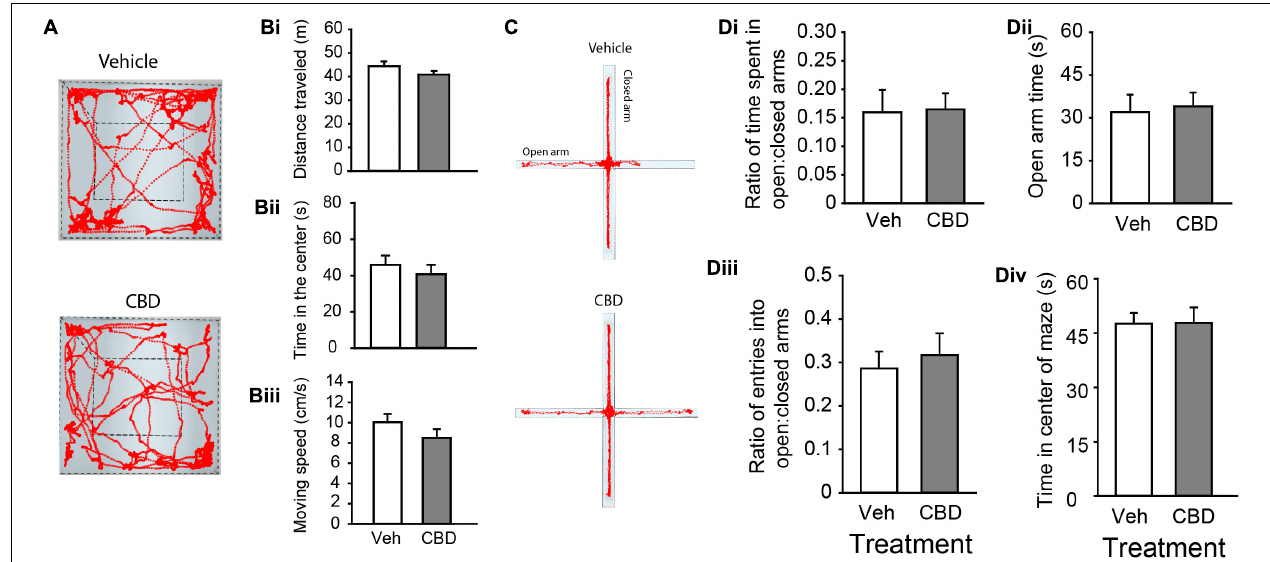
FIGURE 2 | Adolescent CBD exposure does not impact locomotor or anxiety-related behaviors. (A) Representative activity traces in the open field of subjects administered vehicle (top) and CBD (bottom). Summary bar charts indicating that there were no difference in distance traveled between vehicle (white; 44.40 ± 2.04 m) and CBD (gray; 40.84 ± 1.53 m) treated groups (Bi) . There was also no difference in time spent in the center quadrant of the open field chamber between the vehicle (45.91 ± 5.10 s) and CBD (40.81 ± 5.10 s) treated groups (Bii) . There was no difference in the mean moving speed between vehicle (10.05 ± 0.82 cm/s) and CBD (8.51 ± 0.86) treated groups (Biii) . (C) Representative activity traces in the EPM of subjects administered vehicle (top) and CBD (bottom). Summary bar charts indicating that there was no difference in the ratio of time spent in the open arms relative to the closed arms between treatment groups ( Di ; vehicle: 0.16 ± 0.04; CBD: 0.17 ± 0.03). There was no difference in the time spent in the open arms of the EPM ( Dii ; vehicle: 32.10 ± 6.09 s; CBD: 33.9 ± 4.86 s). There was no difference in the ratio of entries into the open arms relative to the closed arms ( Diii ; vehicle: 0.29 ± 0.04; CBD: 0.32 ± 0.05), nor was there a difference in the time spent in the center square of the EPM ( Div ; vehicle: 47.63 ± 2.95 s; CBD: 47.86 ± 4.27